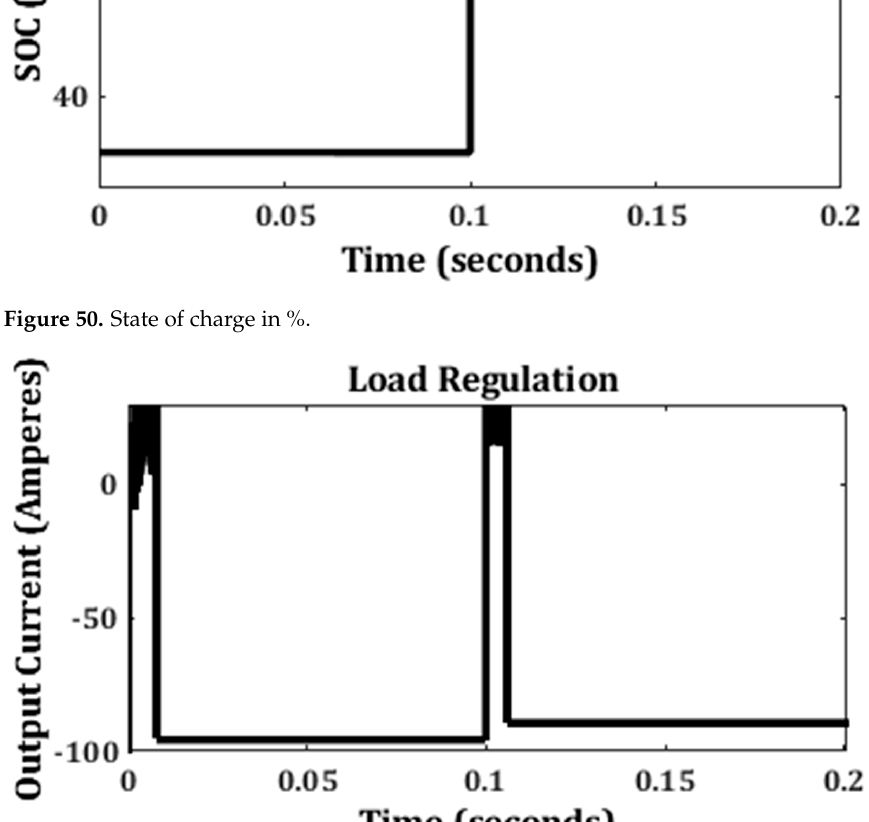
Figure 51. Battery current in Amperes during the load regulation.